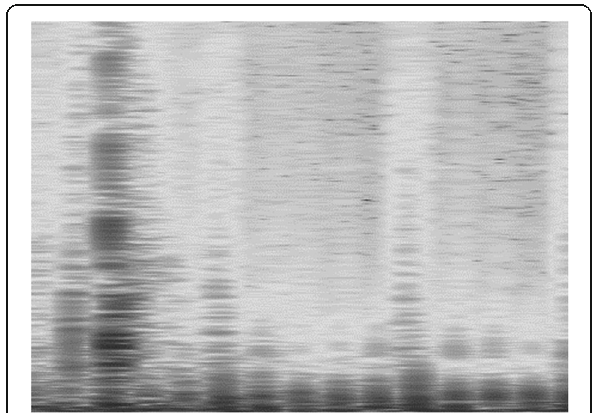
Fig. 2 Example of respiratory sound